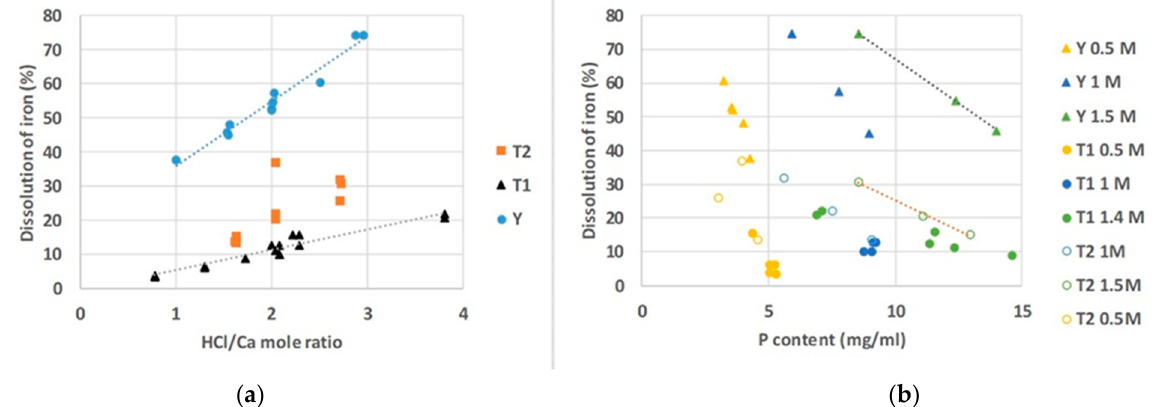
Figure 4. Dissolution of Fe depending on HCl dosage ( a ) and on P content in the solution at different acid concentrations ( b ) where T1 — Toolse 1, T2 — Toolse 2, and Y- Ülgase with the numbers indicating acid molarity.